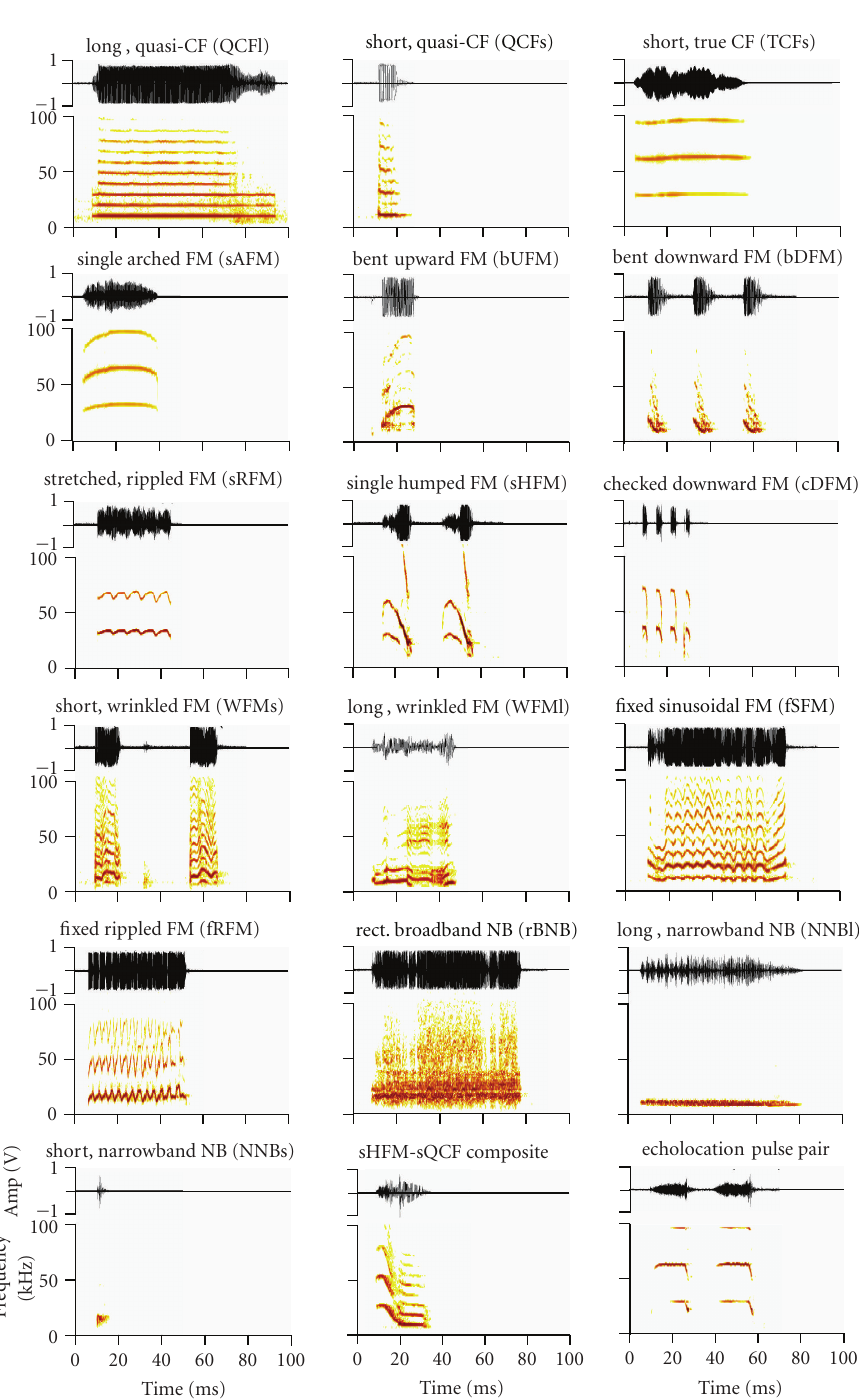
Figure 1: Amplitude envelopes (above) and spectrograms (below) of 16 di ff erent call types emitted by P. parnellii. An example of a composite of the single humped FM (sHFM) and short quasi-CF (QCFs) syllables, as well as a pair of echolocation pulses are also shown. All sounds were digitized at 250 kHz (sampling rate) and band-pass-filtered between 5 and 100 kHz. Spectrograms were produced using a fast Fourier transform (FFT) with a final time step of 1ms. Amplitude range of frequency spectrum was 40 dB or higher. Call examples include sounds emitted by P. p. parnellii and P. p. rubiginosus . Figure adapted from